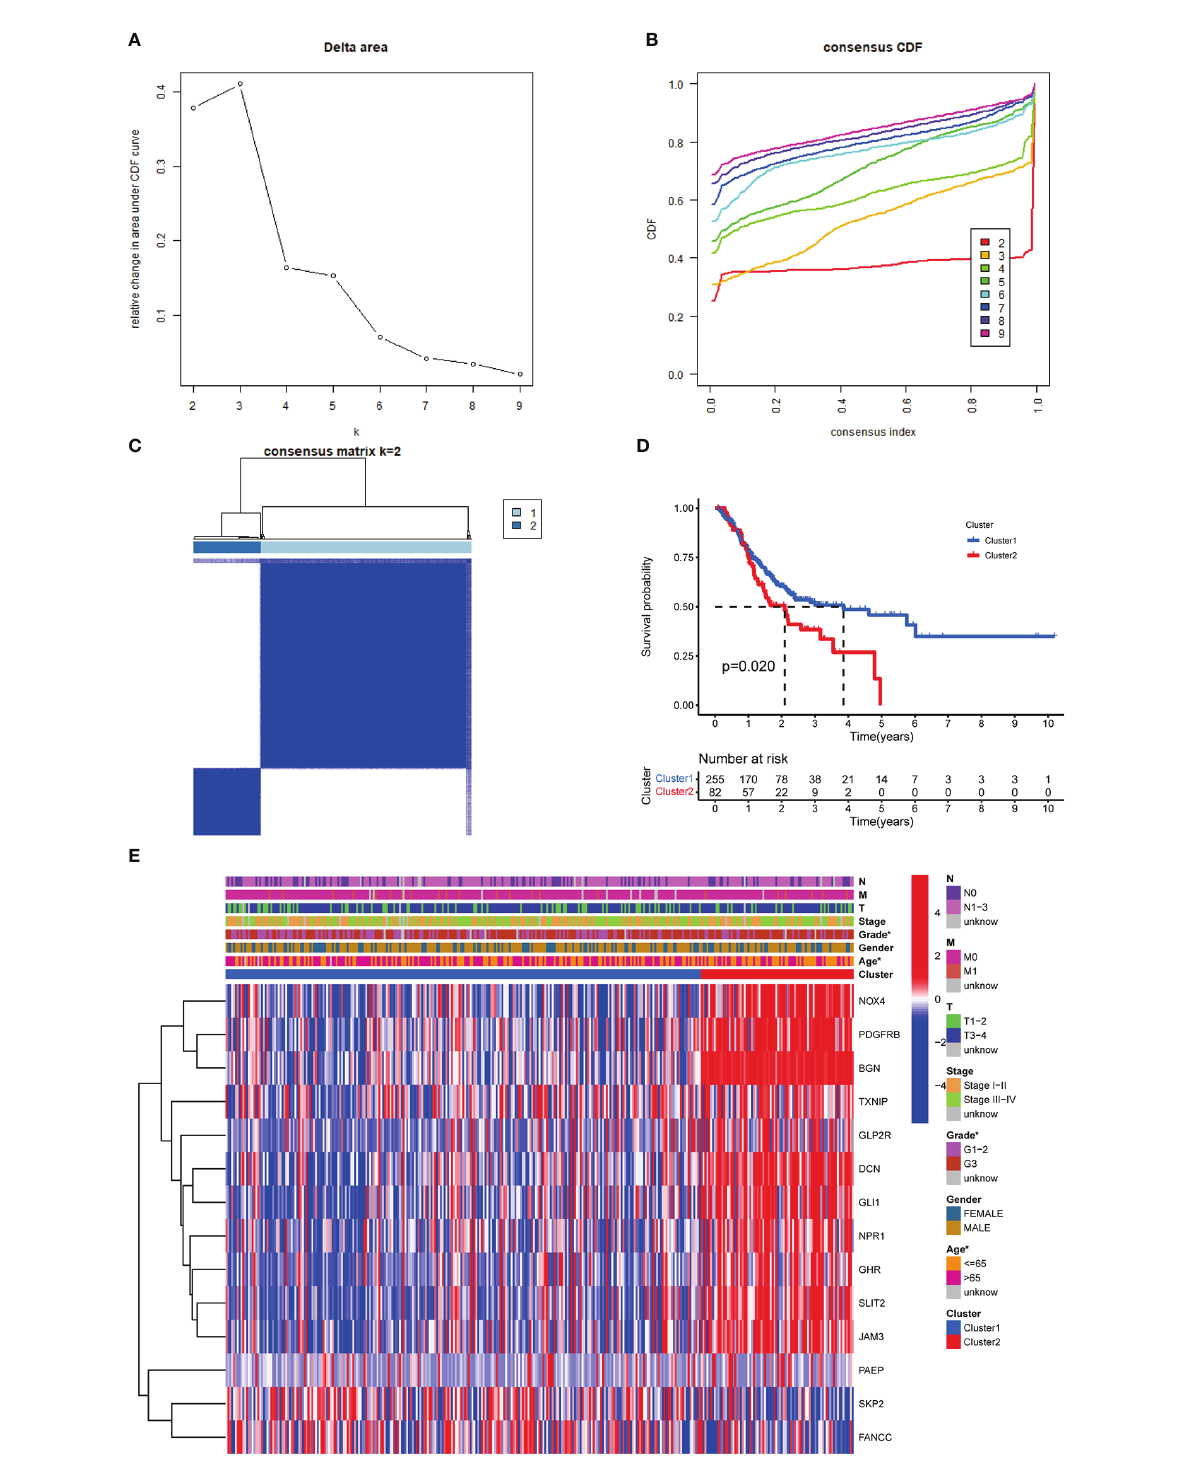
FIGURE 3 Identi fi cation of m 6 AIGs-based clusters of GC samples. (A) The consensus among clusters from 2 to 10 of (k). (B) Delta area curve of consensus clustering. (C) Consensus clustering of GC samples with k = 2. (D) KM analyses for GC patients in clusters I and II. (E) The distribution of clinicopathological characteristics and the expression of 14 prognostic m 6 AIGs in clusters I and II. * p <